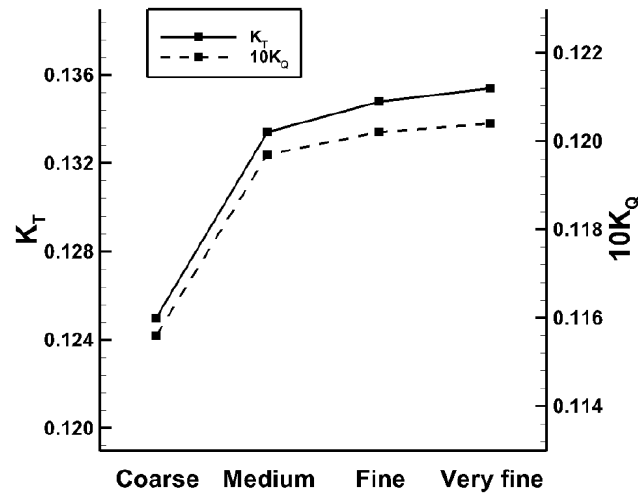
Figure 6. Grid convergence for K T and 10 K Q .